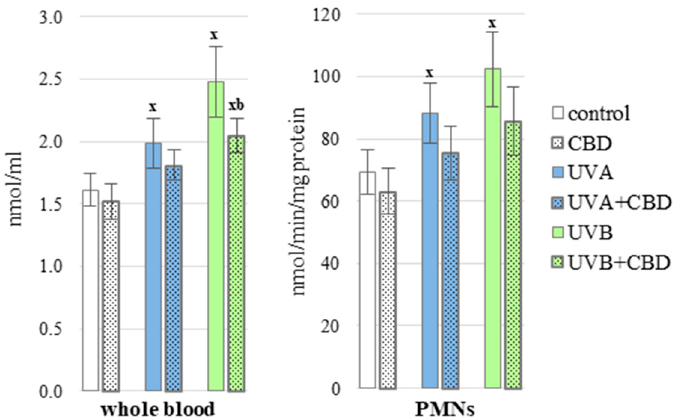
Figure 2. ROS levels in nude rat whole blood and PMNs in the following groups, in the following groups: control; treated with CBD (every 12 h) for 4 weeks; irradiated with UVA (every 48 h) for 4 weeks; irradiated with UVA (every 48 h) and treated with CBD (every 12 h) for 4 weeks; irradiated with UVB (every 48 h) for 4 weeks; irradiated with UVB (every 48 h) and treated with CBD (every 12 h) for 4 weeks. The mean values for six rats in each group ± SD are shown: x—differences vs. control group, p < 0.05; b—differences vs. UVB treated group, p < 0.05.